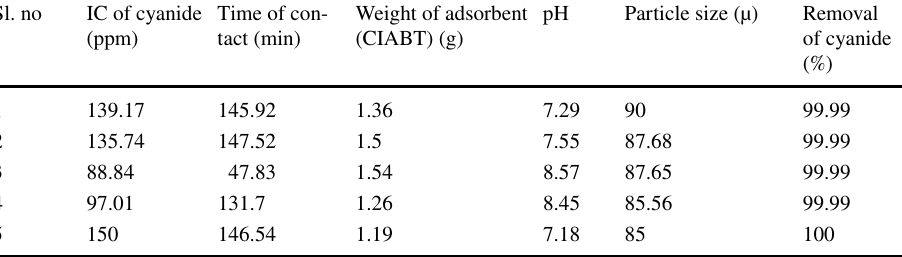
responses and corresponding operating parameters obtained by particle swarm optimization (PSO) for removal of cyanide